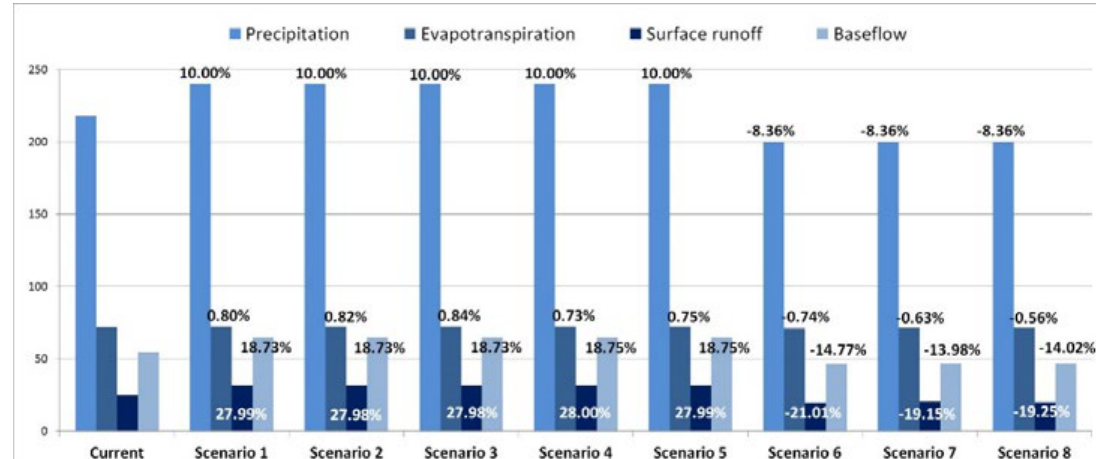
Fig. 5: Percentage change of land cover and climate change scenarios from current values on precipitation (mm/y), evapotranspiration (mm/y), surface runoff (mm/y), and baseflow (mm/y) within the Muleta watershed.